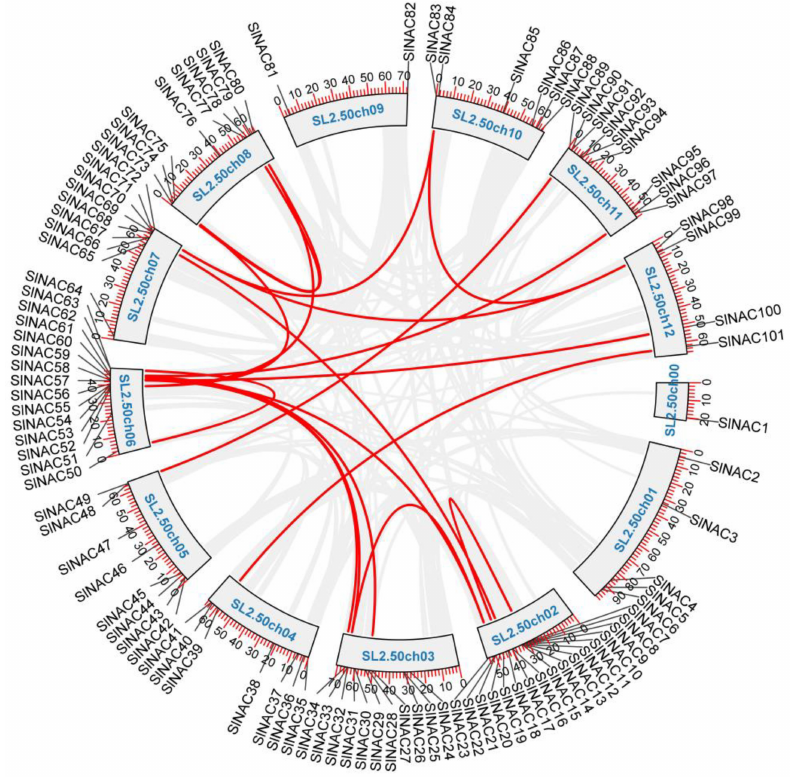
Figure 3. Chromosomal distribution and collinear relationships of the SlNAC genes. The duplicated gene pairs are joined by red